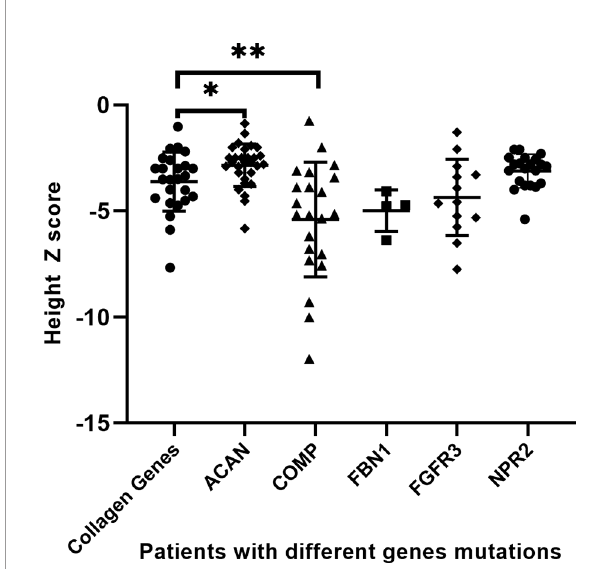
FIGURE 3 | Comparison of different gene mutations leading to growth retardation. *p <.05, **p